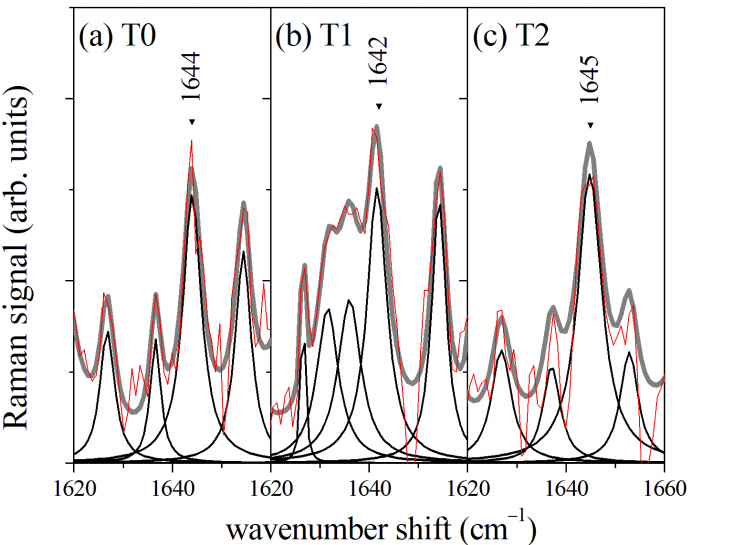
Figure 2. ( a ) Average Raman signal of GCF from control samples before starting the orthodontic process (T0); ( b ) Average Raman spectrum of GCF from samples collected after 2 days of orthodontic process (T1); ( c ) Average Raman spectrum of GCF from samples collected after 7 days of orthodon- tic process. The red lines refer to the measured signal and are compared with the envelope (gray line) of evaluated mode components (black